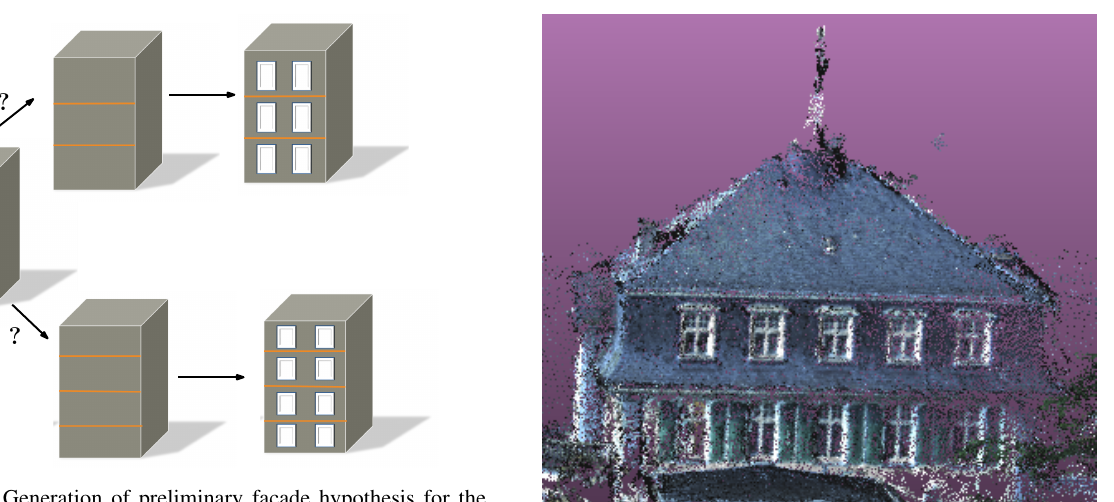
Figure 6: Generation of preliminary facade hypothesis for the mission planing according to the objectives of the mission from figure 1. A-priori unknown floor numbers and facade parts are estimated.